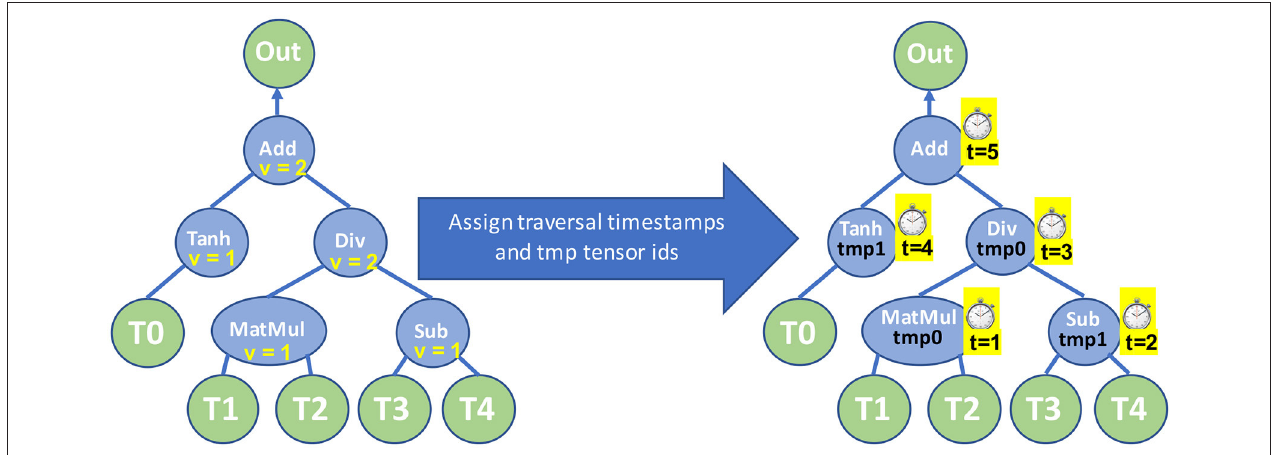
FIGURE 13 | Left: TPP equation tree with assigned register scores v on the nodes. Right: TPP equation tree with assigned traversal timestamps t and temporary tensor ids tmp after executing Algorithm 4 .